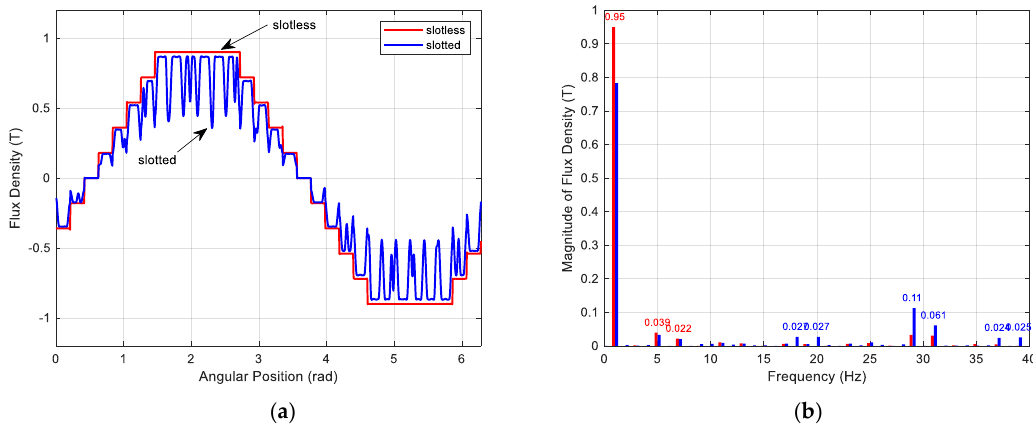
Figure 1. ( a ) Air gap field generated by 3-phase winding; field distribution ( left ), ( b ) frequency spectrum ( right ).